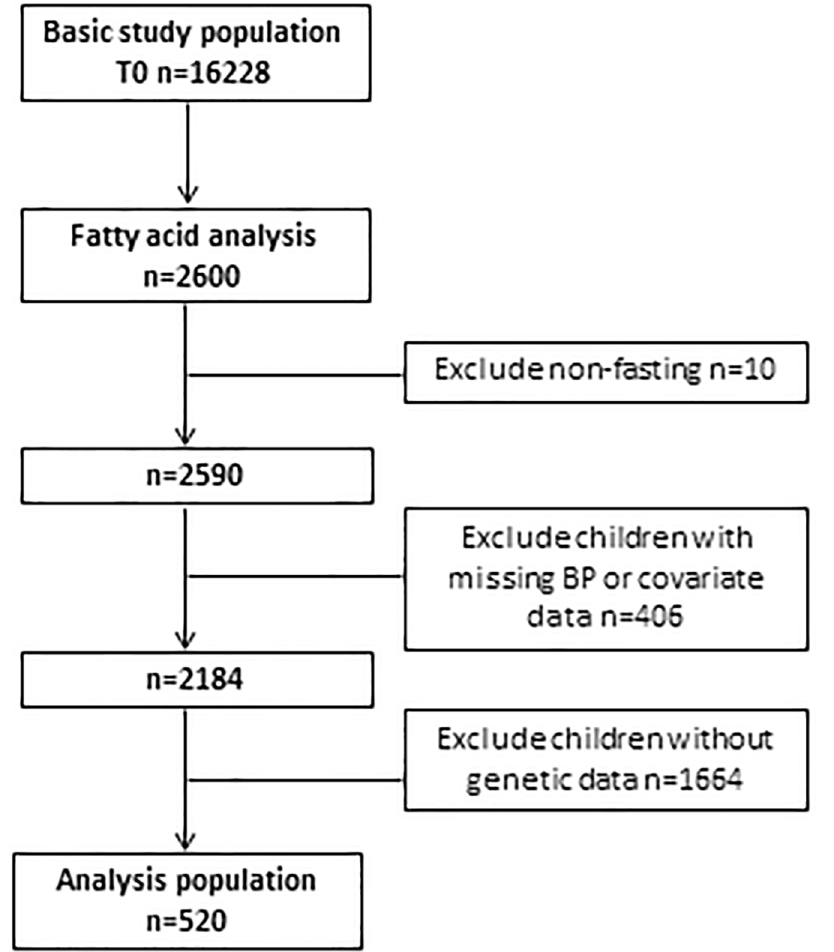
Fig 1. Flow chart of the inclusion and exclusion of IDEFICS